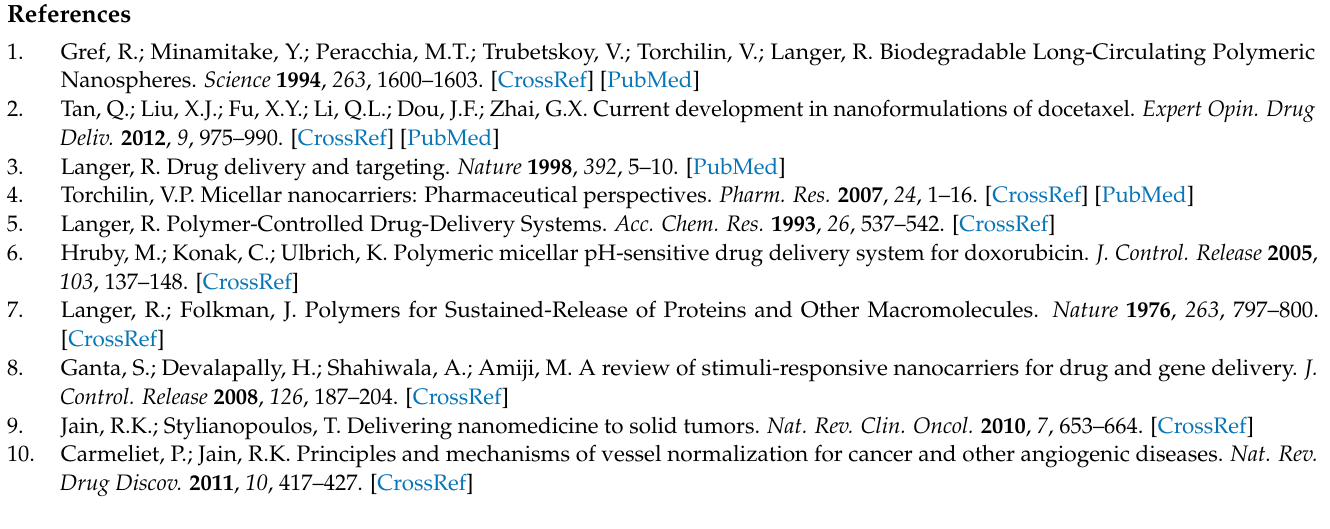
irradiation. Figure S3: DLS size distribution and TEM image of DTX-NP oct . Figure S4: DLS measurement of size change of NR-NP Oct in BSA solution. Figure S5: HUVECs Viability of Polymers (PEG-PLL-DNQ & PEG-PLL-Oct). Table S1: Measurement of Drug Loading Efficiency (LE) and Capacity